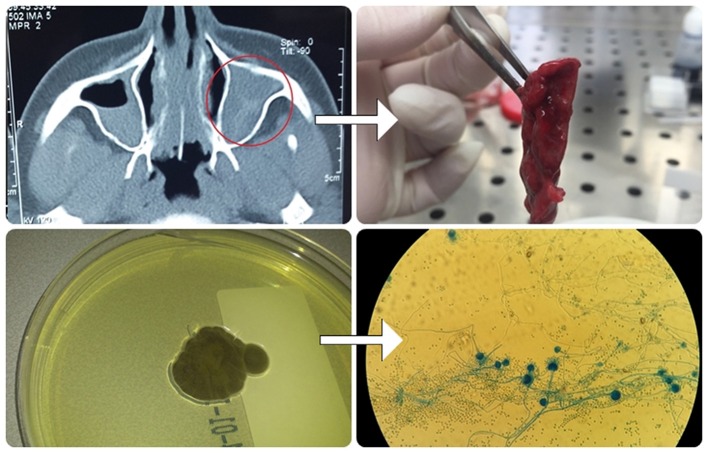
Algorithm for fungal detection in the sinuses: CT imaging of paranasal sinuses of patients with ABPA revealed AFRS; Aspiration of allergic mucin was done, processed and used for mycological examination by microscopy and culturing.